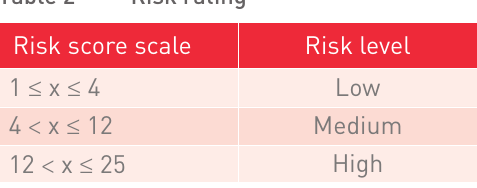
Risk rating Risk score scale Risk level 1 ≤ x ≤ 4 Low Medium